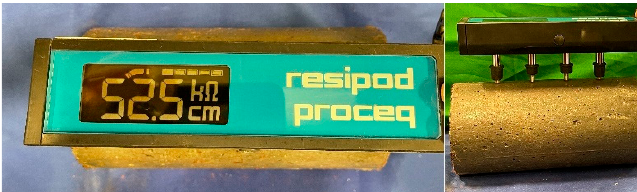
Figure 5. Surface resistivity test.